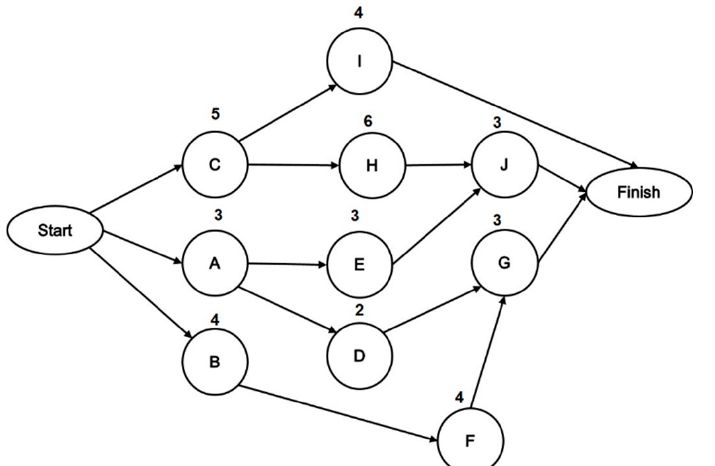
Figure 1. Overview of research methodology. Table 2. Project information for project A.